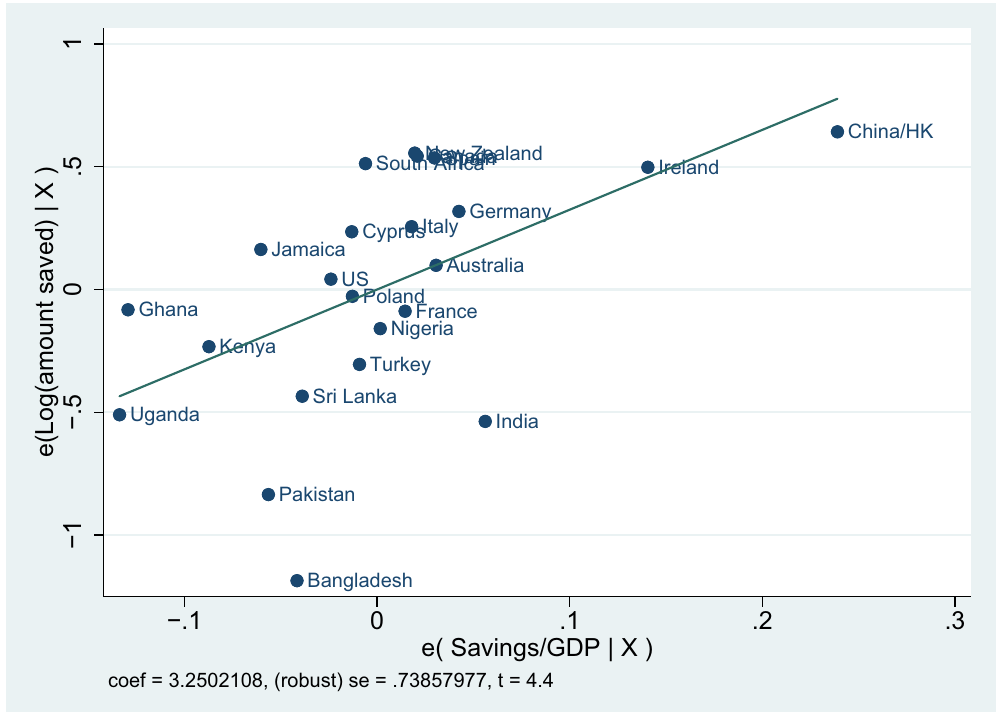
Fig 1. Partial correlation plot: Log (amount saved) for first generation immigrants. Log (amount saved) for first generation immigrants is the logarithm of the self-reported monthly amount of saving. The saving rate in the countries of origin indicates the average gross domestic savings over GDP from